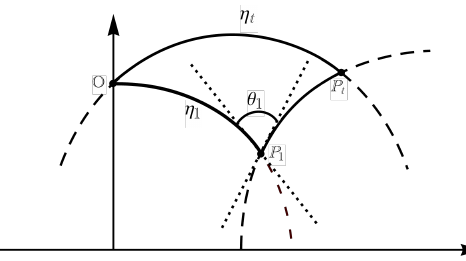
Figure 3. Distance travelled after the first Poisson